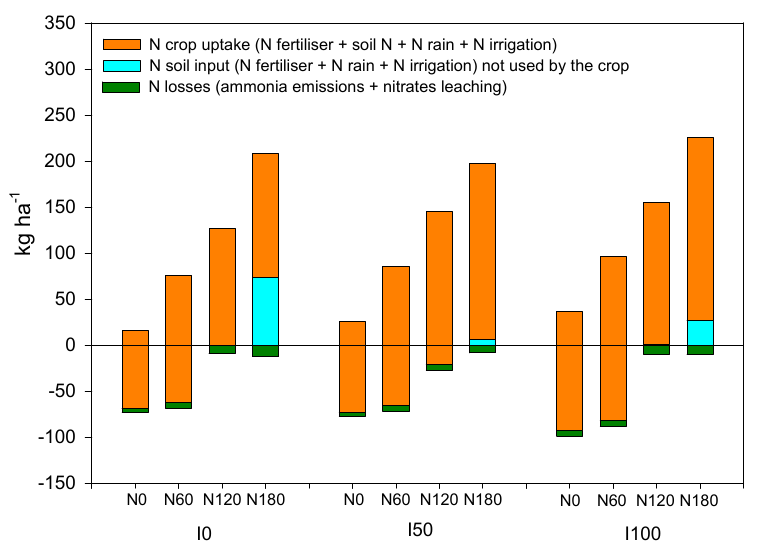
Figure 7. N mobilisation (kg ha − 1 ) in the soil–plant–atmosphere system in a sweet sorghum crop (cv. Keller). For crop N uptake (orange bars), negative values indicate crop N-soil reserve uptake, and positive values indicate crop N-fertilizer uptake + N irrigation water + N rain. Cyan bars indicate N fertilizer + N irrigation water + N rain not used by the crop and left in the soil. Consequently, the difference between N input (N fertilizer + N rain + N irrigation water) and output (N crop uptake + ammonia emissions + nitrate leaching), irrespective of water supplied, increased with the N applied to the crop, from negative (from − 82.5 to − 11.6 kg ha − 1 , in N0 and N120, respectively) to positive values (+21.1 kg ha − 1 in N180). Thus, the sweet sorghum crop was able to recover high amounts of N from the soil